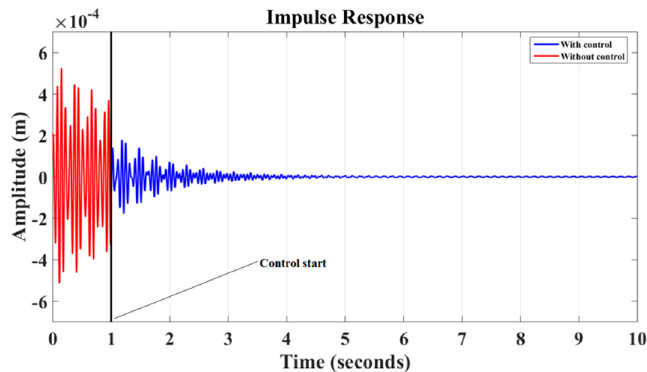
Figure 14. White noise response (Sensors in FE3, Q = 10 10 , R = 1, Gc = 100).